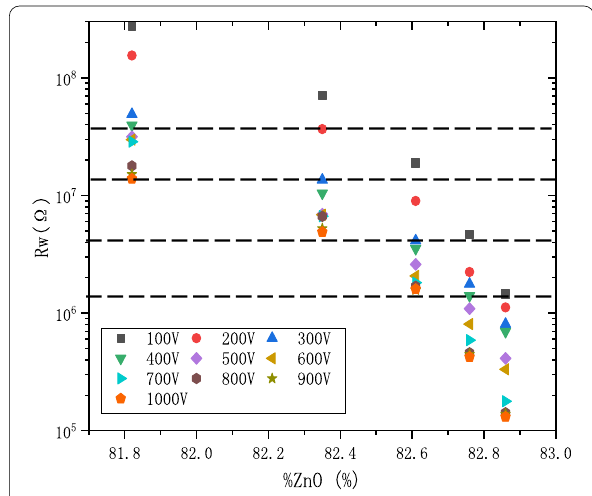
Fig. 10 The working resistance with the percentage of ZnO cycles diagram at the different voltage